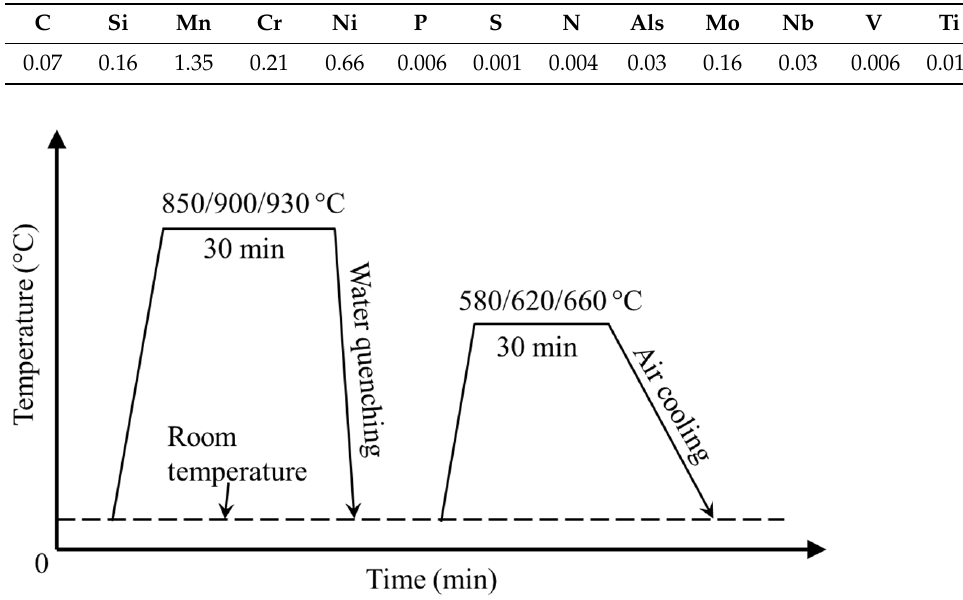
Figure 1. Heat treatment strategies with different quenching and tempering processes. Table 2. Detailed parameters for various heat treatment processes.